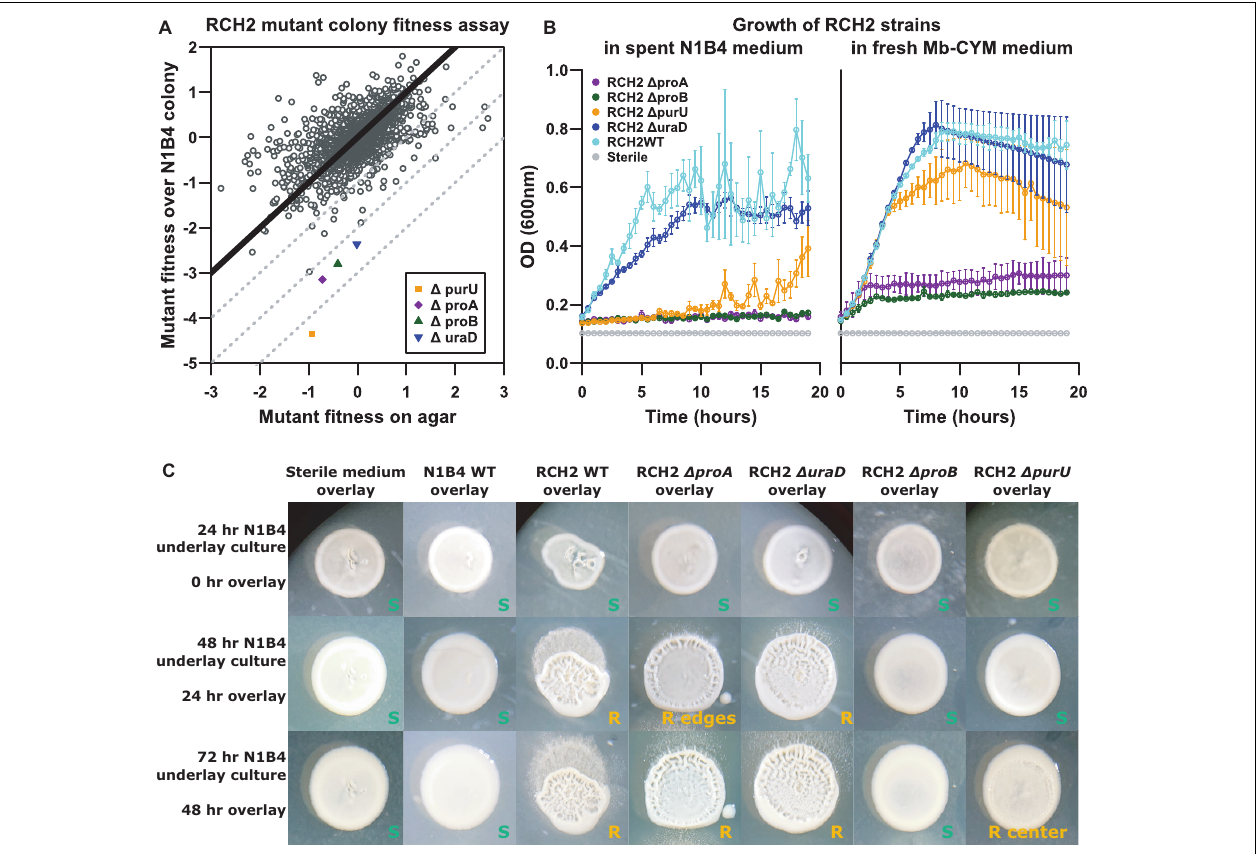
FIGURE 4 | RCH2 mutant co-colony interactions. (A) RB-TnSeq mutant library fitness assay, (B) mutant growth on N1B4 spent and fresh media, (C) mutant growth on N1B4 colonies. All strains of RCH2 grew alone (on control sterile medium underlay) and formed rugose colonies by 24 h of overlay culture ( Supplementary Figure 3 and Supplementary Table 5 ). Images are notated with “S” or “R” for smooth or rugose morphology, respectively; location noted when rugose morphology was located only in the center or periphery of the colony.